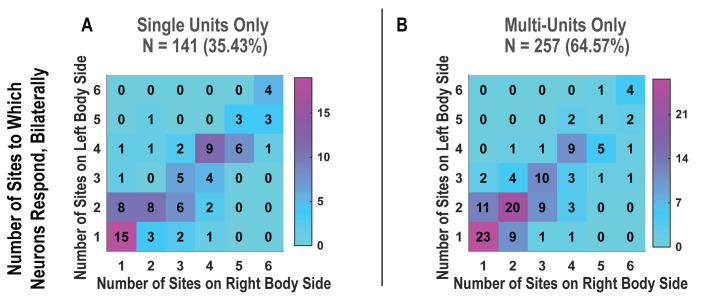
Bilateral responses to actual touch are not qualitatively changed by pooling together single and multi-units.(A) Matrix showing the number of neurons that responded to the number of body parts shown, along each of the left and right body sides. Only high-quality single units were considered in this matrix. The number of neurons is overlaid upon a heatmap in which the colors correspond to the number, as in the scale. (B) Similar to A, but considering potential multi-units. N: sample size; L: left; R: right.